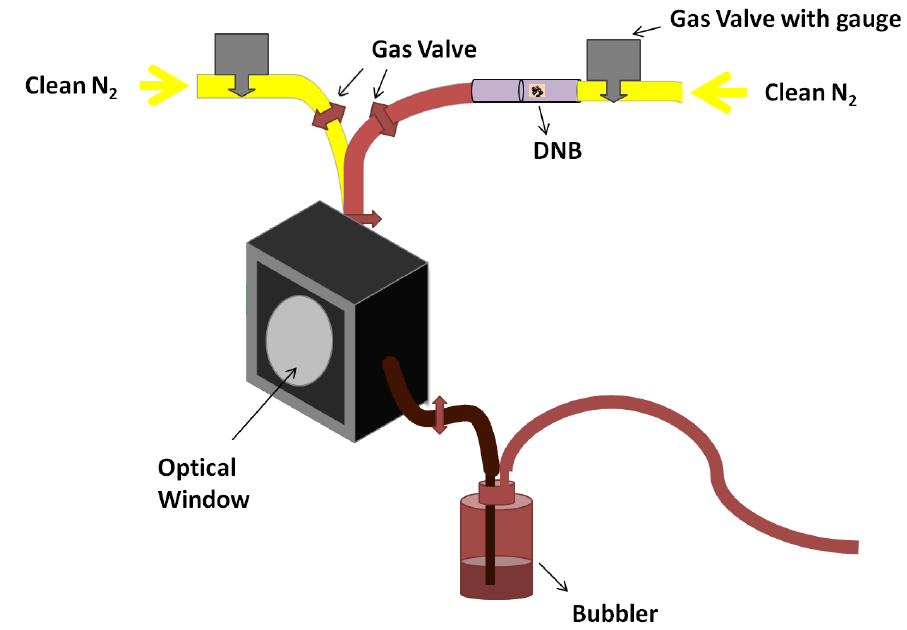
Figure 2. Sketch of the experimental